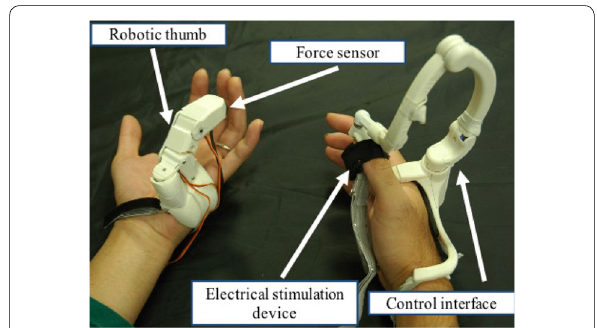
Fig. 2 The overall image of the extra robotic thumb. The robotic thumb is mounted on the left palm and the control interface is mounted on the right